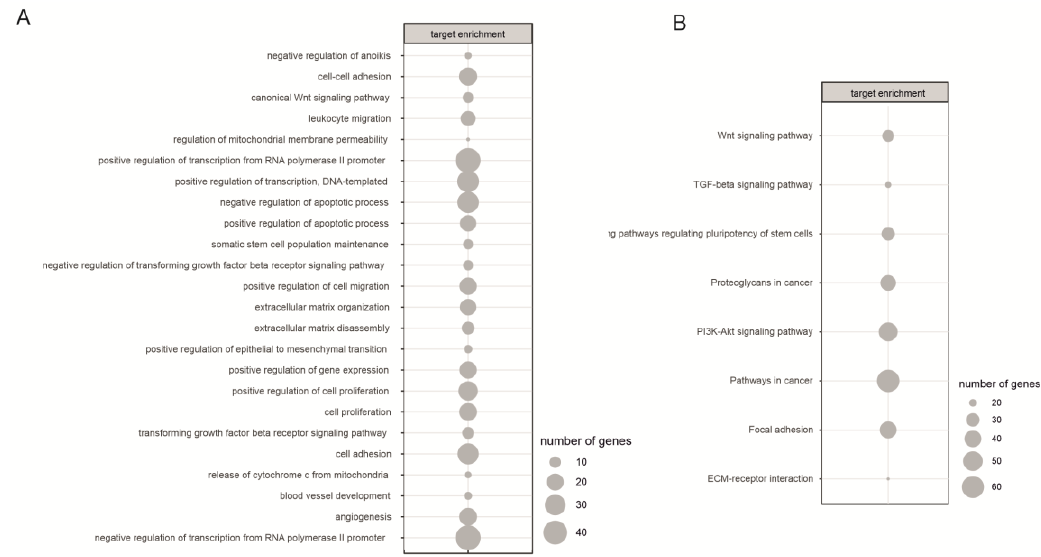
Figure 4. Analysis of biological processes regulated by differentially expressed miRNAs target genes (DAVID software) revealed processes characteristic for neural differentiation ( A — Gene Ontology database, B — KEGG database).